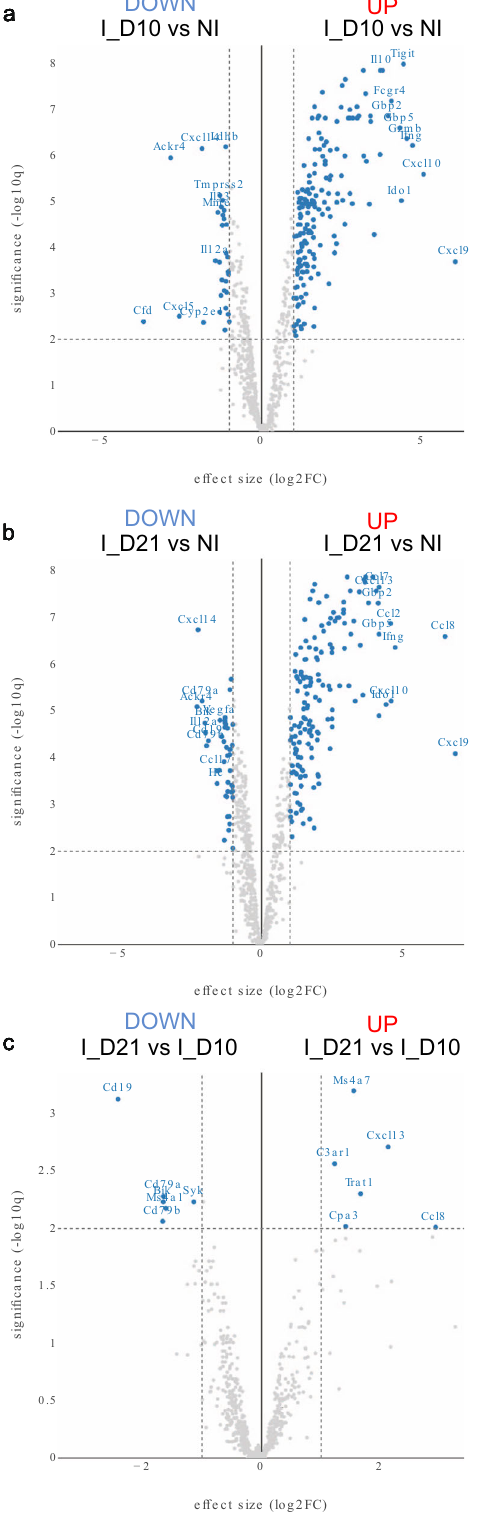
SEMofgeneexpressioninlungtissueat10( n =3)and21dpi( n =3)comparedtoNI ( n =6) mice. e Overview of the DE g e nes between 21 dpi ( n =3) and 10 dpi ( n =3) mice, with the largest fold change (Log2FC>2,Log2FC< − 1). Graphs represent the Log2FC±SEM of gene expression between 21 dpi and 10 dpi. Created using Omics